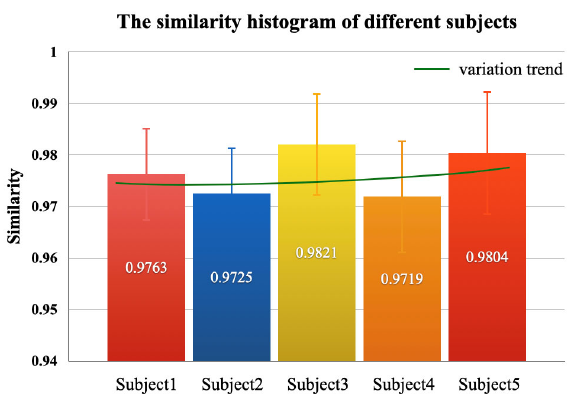
Figure 10. The similarity histogram of each subject.